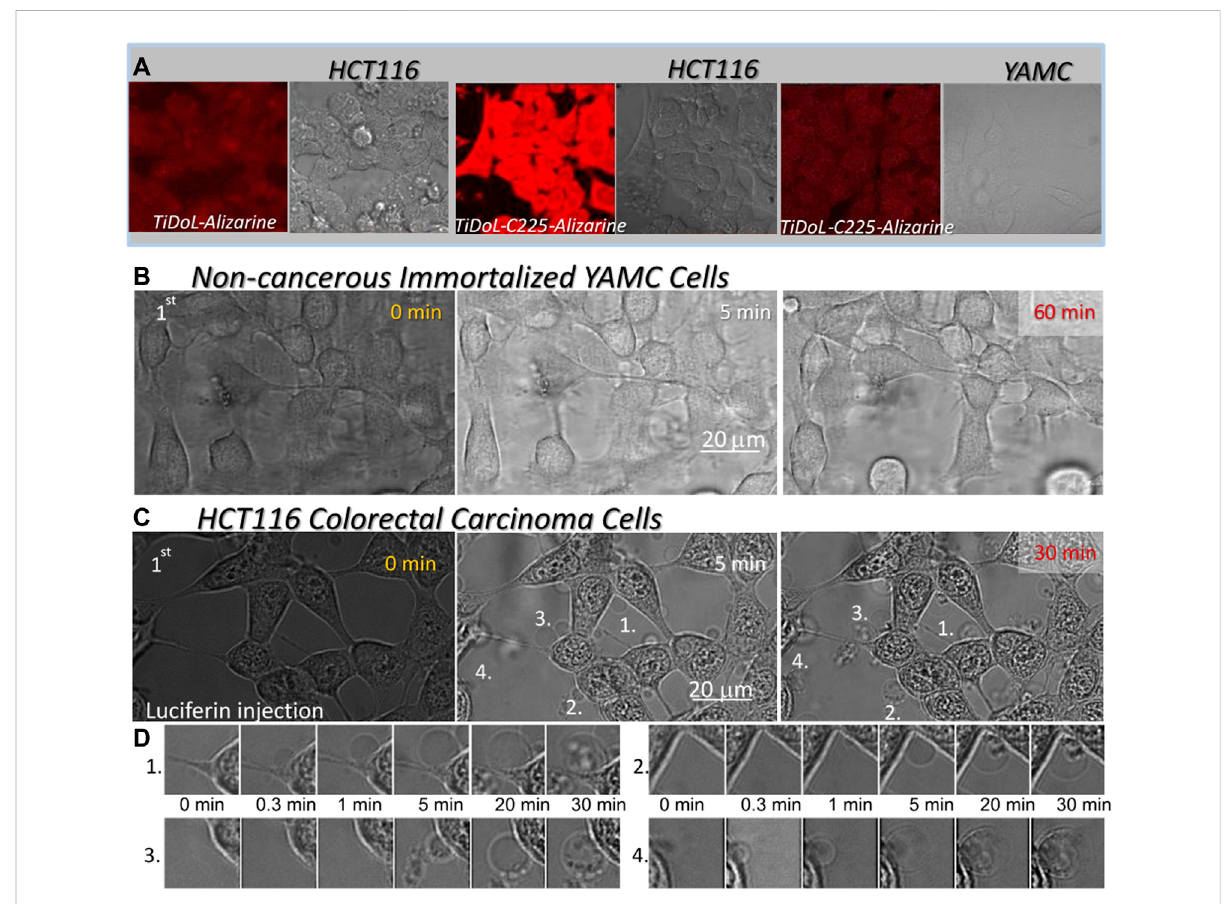
FIGURE 4 (A) Adsorption of nanoconjugates w/o the C225 antibody on HCT116 cells and EGFR(-) immortalized young adult mouse colon (YAMC) cells. Nanocomposites are visualized by imaging fl uorescence of alizarin bound to TiO 2 nanoparticles (red) using laser excitation 560 nm and cells (gray) are imaged in the transmission mode. Magni fi cation ×40. (B) Time course of the morphological changes of the YAMC colon cell line treated with 150 nM TiDoL-C225. Magni fi cation ×126. (C) Time course of the morphological changes of the HCT116 colon cancer cell line treated with 150 nM TiDoL-C225All conditions are the same as in Figure 2B and budding of the cells starts 30 s after fi rst luciferin injections. Magni fi cation ×126. (D) Time course of formation, growth, and transfer of cell material to the apoptotic bodies after the fi rst luciferin